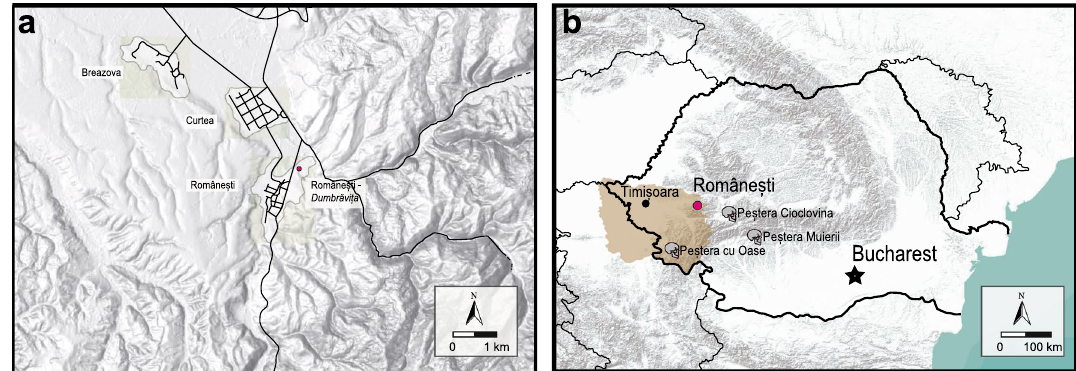
Figure 1. Position of Române ș ti- Dumbrăvi ț a ( a ) near the eponymous village in the Banat region; and ( b ) within Romania. The Banat is shaded in brown (Projection is latitude–longitude